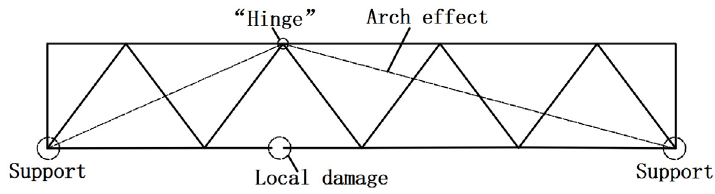
Figure 12. Arch mechanism after the failure of the lower chord. After the initial failure of the web member, the substructures will be joined by two connections, the upper chord above the damaged element and the lower chord below the damaged element, respectively. Both the arch effect developed in the upper chords and the catenary action in the lower chords exist in the structure (Figure 13).